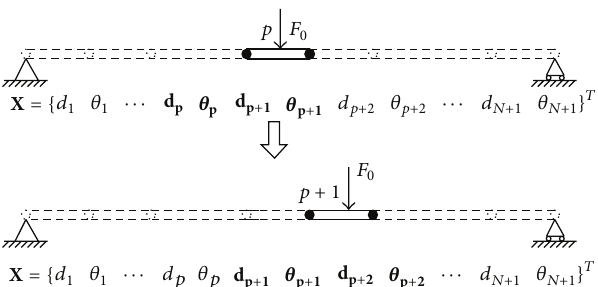
Figure 4: Selecting the master DOFs in the condensed